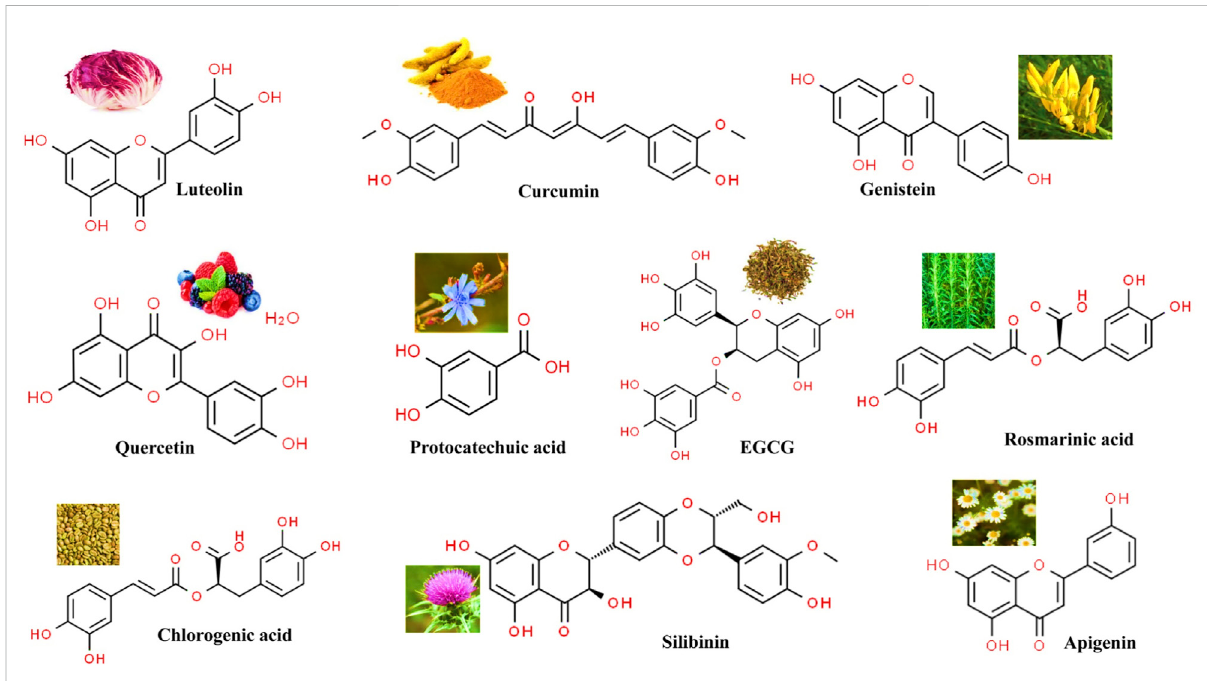
FIGURE 1 Chemical structures of most representative polyphenols employed as anticancer